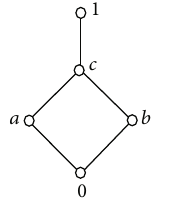
Figure 1: The complete lattice diagram.